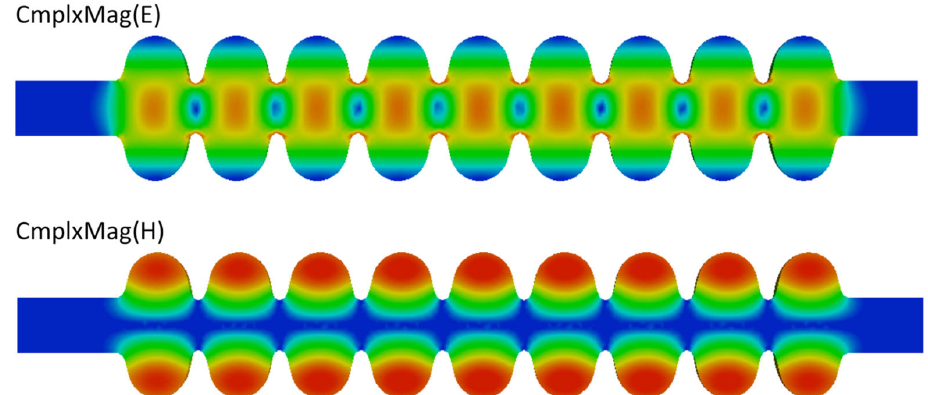
FIG. 5. Complex magnitudes of electric (top) and magnetic (bottom) fields (a.u.) for the 1.3 GHz acceleration mode color coded on a linear